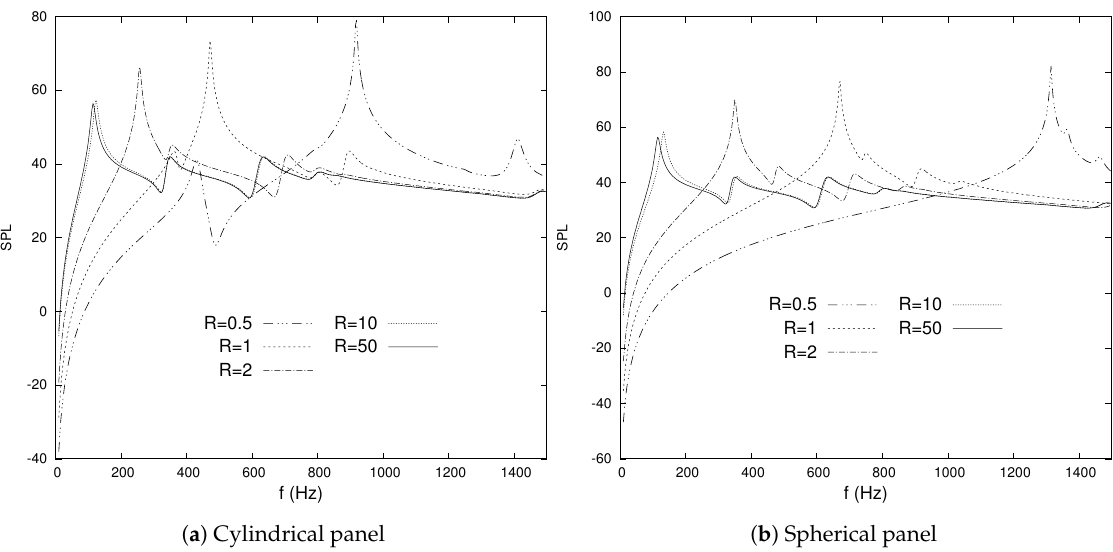
Figure 9. Transmitted sound power level ( SPL ) of the rectangular cylindrical and spherical shells with simply-supported boundary conditions for all the edges, for different mean radii.